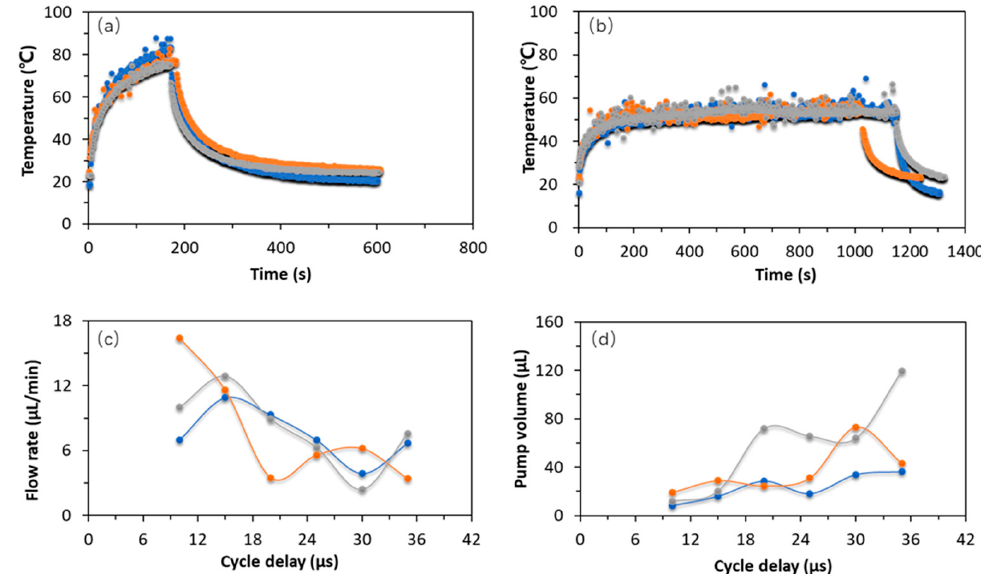
Figure 3. ( a ) Temperature curves of micropumps at room temperature. ( b ) Temperature of micropump under water cooling condition. ( c ) The effects of cycle delay time on flow rate. ( d ) The relationship between pump volume and cycle delay time. (Three colors represent three replicates).